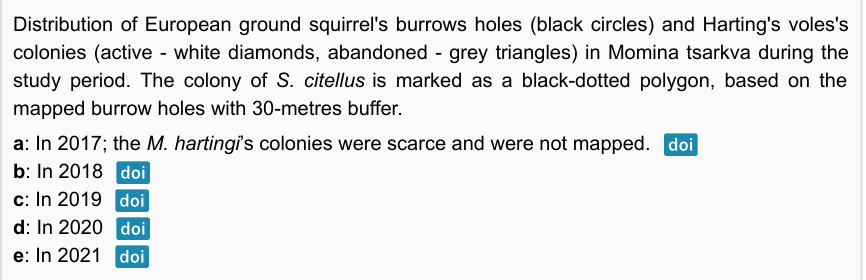
The hydrothermal coefficient (HTC) showed that the period between July and September was the driest. The fluctuations in HTC were strongest in spring, especially April and June.